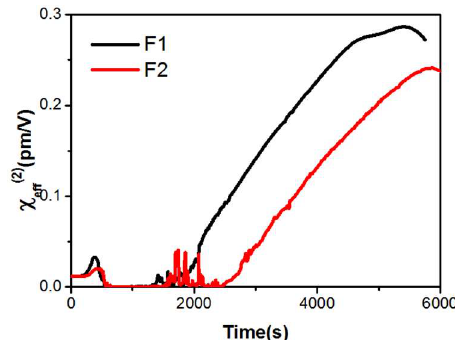
Figure 5. Time evolution of the effective second-order nonlinear coefficient at the fibers F1 (black) and F2 (red) core center.